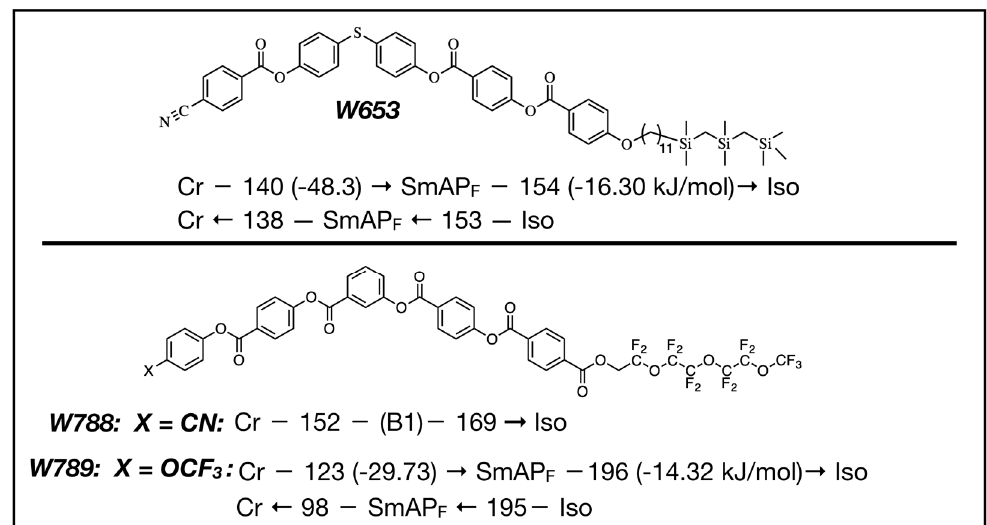
Figure 3. Structures, phase sequences, transition temperatures (°C) and transition enthalpies on heating (kJ/mol) by differential scanning calorimetry (DSC), of the new mesogens. The thio-bisphenol ester W653 possesses an enantiotropic SmAP F phase, which transitions directly to isotropic on heating. W788 , the PF- PEG analog of W586 , exhibits only a monotropic B1 (columnar) phase on cooling. W789 , possessing a trifluoromethoxy tail in place of the cyano group of W586 , exhibits a wide temperature range (almost 75 °C) enantiotropic SmAP F phase. The details of the phase assignments are given below.